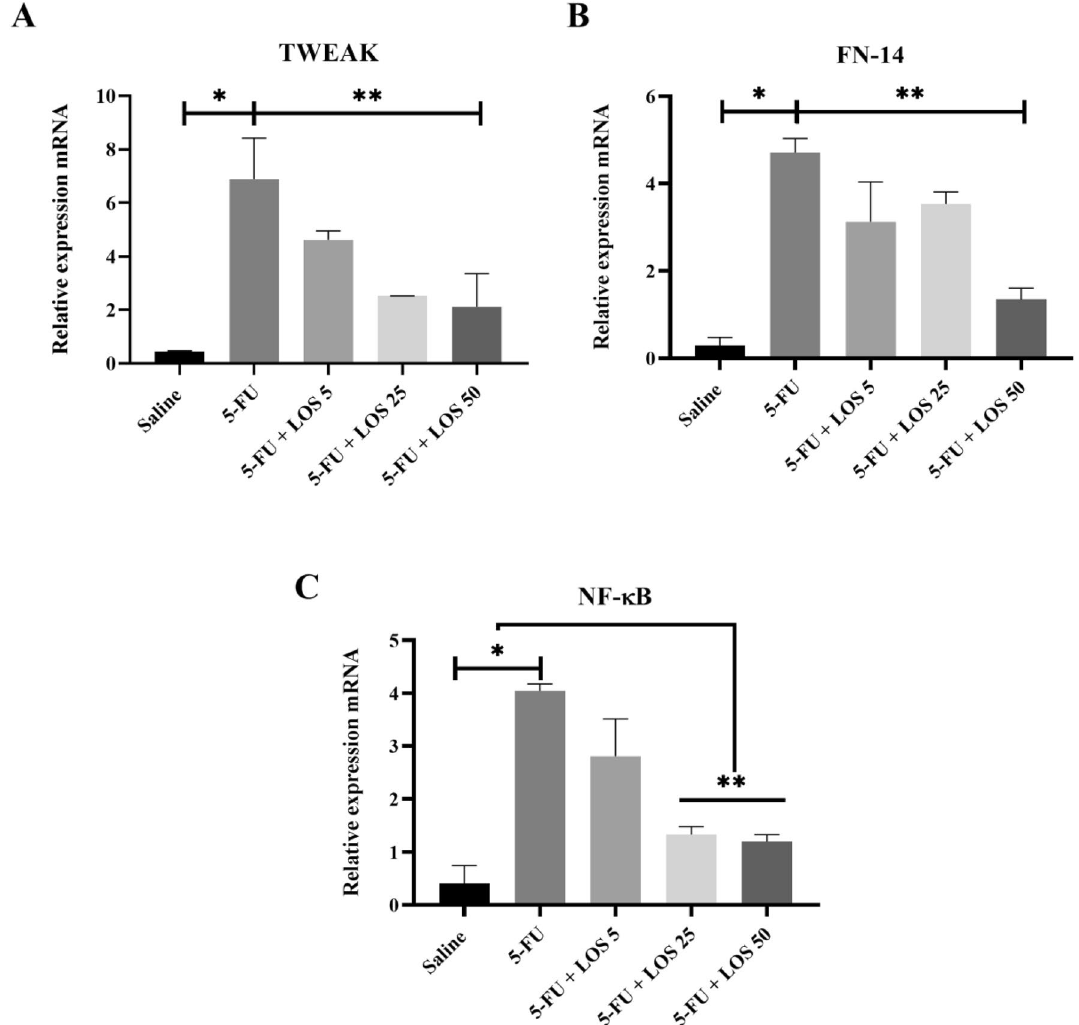
Figure 6. Polymerase chain reaction in real time for TWEAK, Weak apoptosis inducer like cytokine tumor necrosis factor ( A ); FN-14, inducible fibroblast growth factor 14 ( B ); NF-κB p65, the nuclear transcription factor kappa B ( C ). 5-Fluorouracil (5-FU) increased the expression of these genes compared to the Saline group. Losartan decreased the expression of TWEAK, FN-14 and NF-κB p65, compared to the 5-FU group (n = 5); *p < 0.05 compared with the Saline group; **p < 0.05 compared with the group 5-FU; analysis of variance with Tukey’s